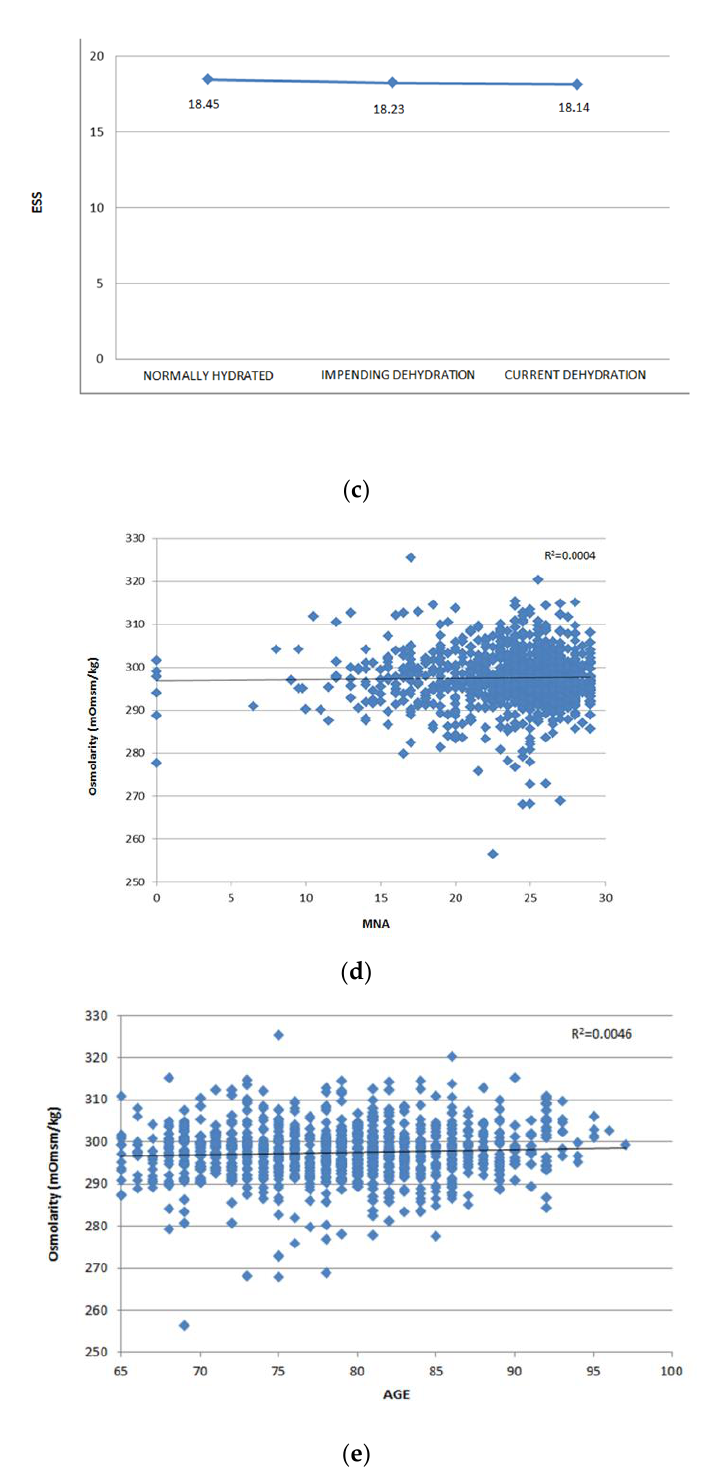
Figure 2. ( a ) Multivariate analysis of dehydration risk according to Activities of Daily Living (ADL) scores; ( b ) multivariate analysis of dehydration risk according to Instrumental Activities of Daily Living (IADL) scores; ( c ) multivariate analysis of dehydration risk according to Exton-Smith Scale (ESS) scores; ( d ) linear regression model of dehydration risk according to age of patients; ( e ) linear regression model of dehydration risk according to Mini Nutritional Assessment (MNA) scores.